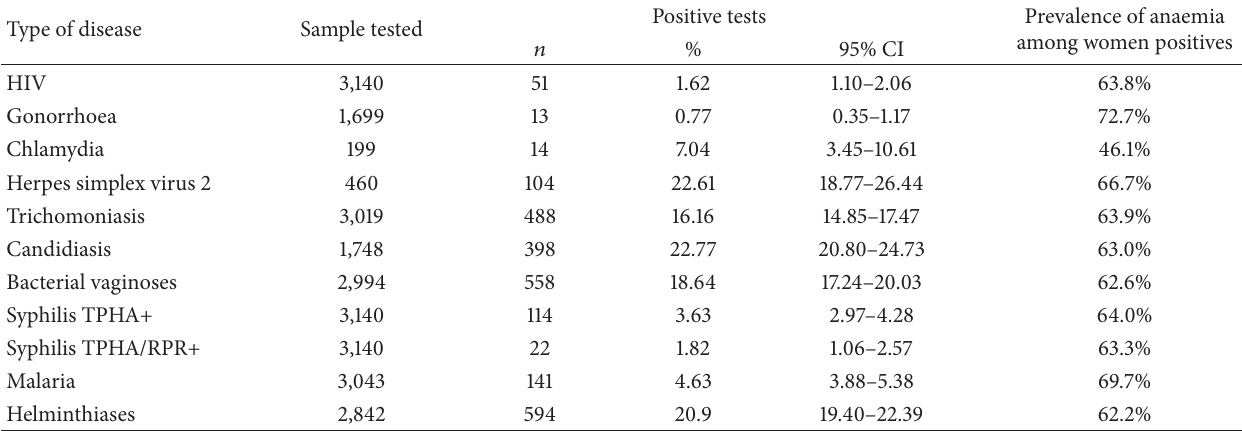
Table 2: Prevalence of infectious diseases among pregnant women in Hound´e health district, Burkina